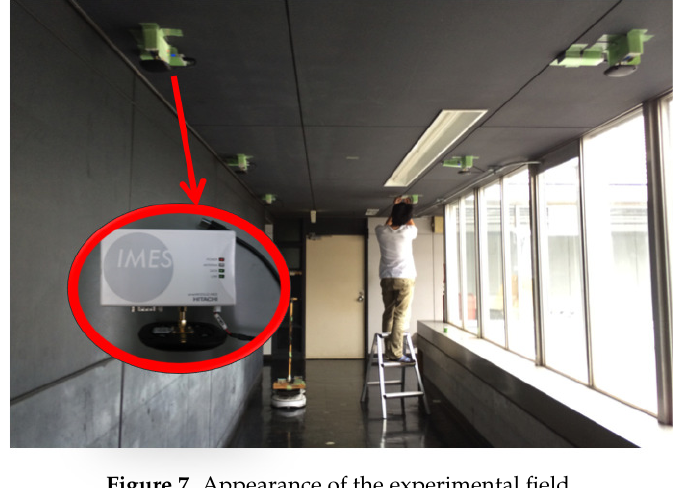
Figure 7. Appearance of the experimental